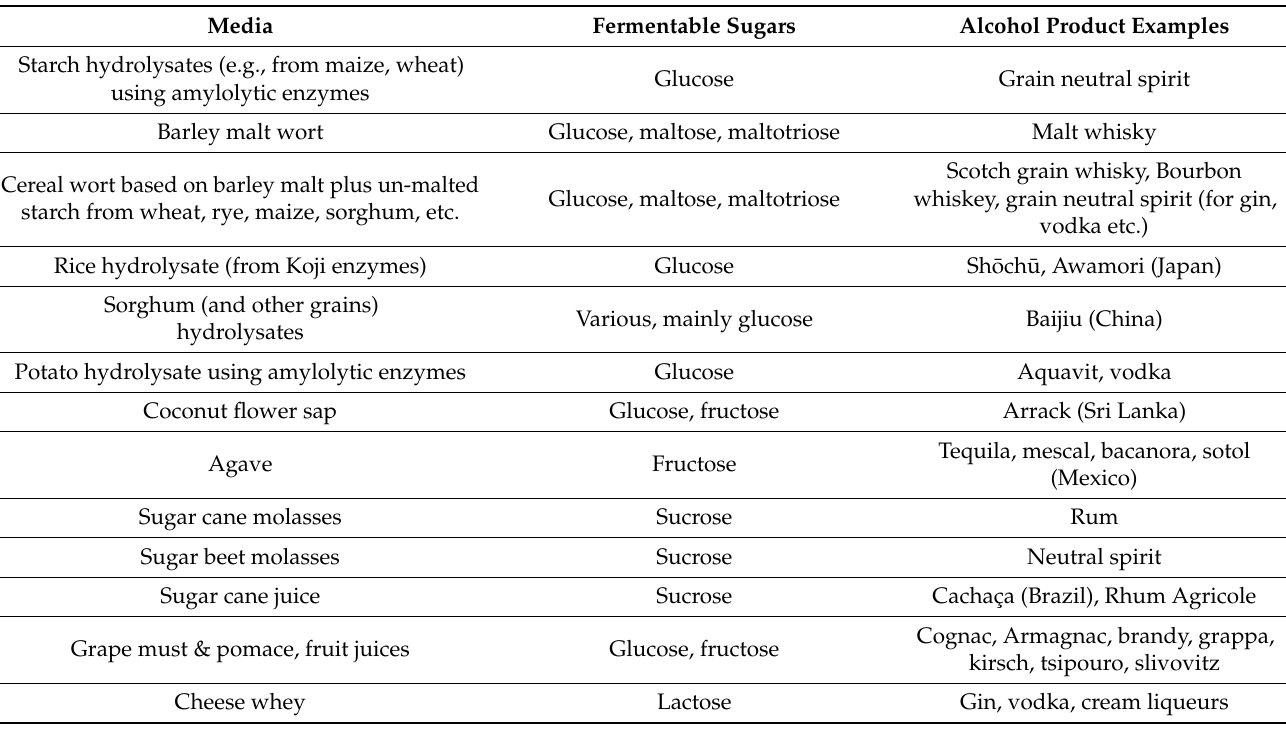
Table 2. Some fermentation media for the production of distilled spirits. (Adapted from